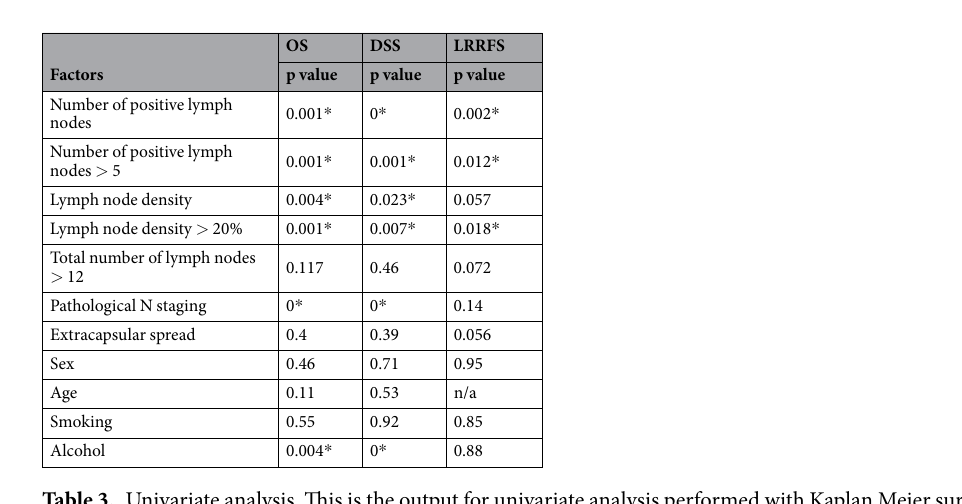
Table 3. Univariate analysis. This is the output for univariate analysis performed with Kaplan Meier survival estimates. Notes: OS = overall survival; DSS = disease specific survival; LRRFS = locoregional recurrence free survival. LRRFS was not calculated for age due to censoring of data. Univariate analysis of total number of lymph nodes as a continuous variable was not performed as data was